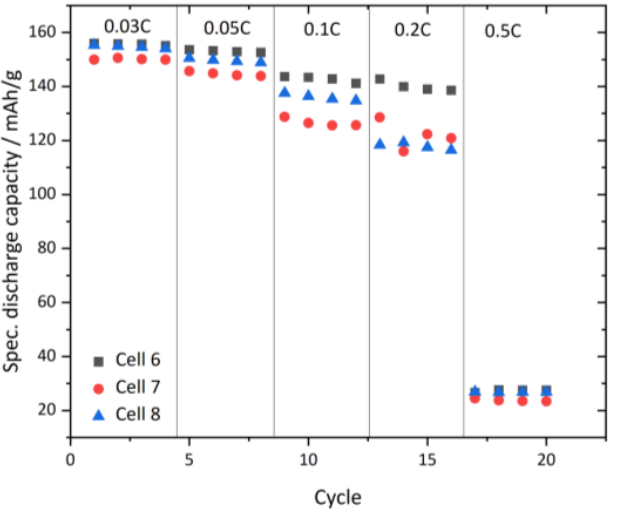
Figure 11. C-rate testing of full cells with infiltrated and laminated NCM and LTO electrodes, at 45 °C.